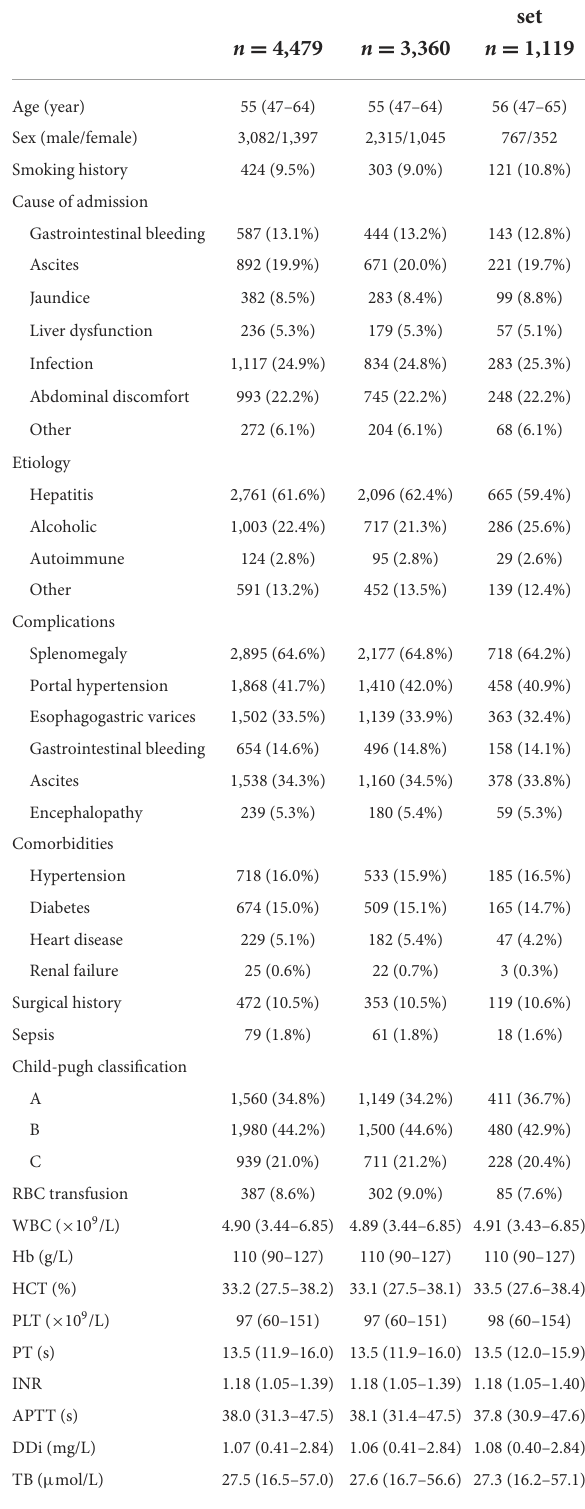
TABLE 1 Demographics, clinical and laboratory data of patients with cirrhosis. Variable All patients Training set